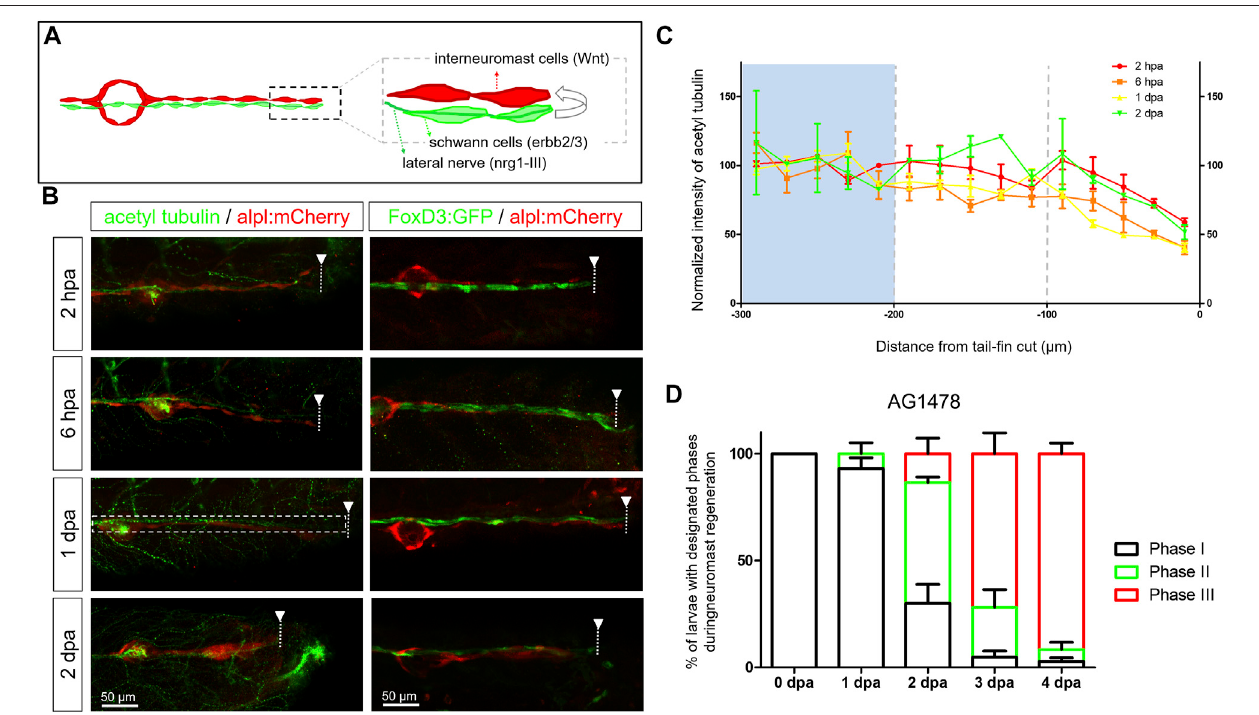
FIGURE3| Diminishednerveinhibitionnearthecutsitemayallowneuromastregenerationfrominterneuromastcells. (A) Agraphshowstheclosecontactbetween interneuromast cells (INCs, red) with underlying Schwann cells (SWCs, light green) and posterior-lateral nerve (pLLn, dark green). The pLLn-derived nrg1-III can